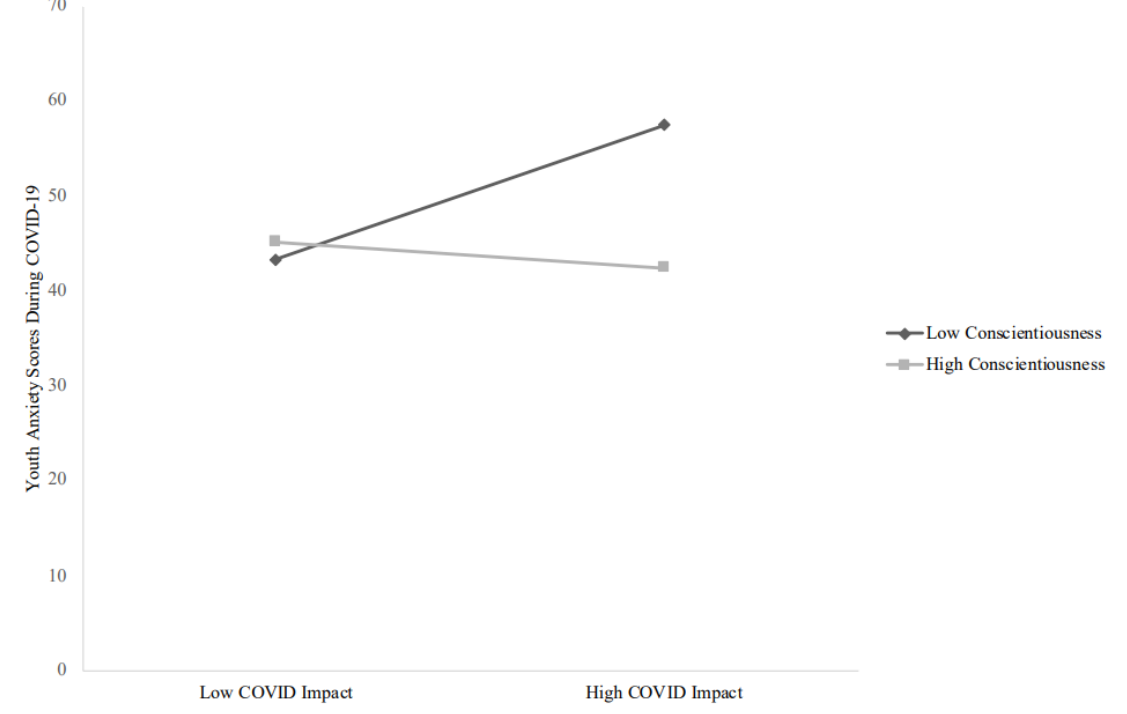
Figure 1. Interaction between COVID-19 impact and levels of conscientiousness on change in youth anxiety symptoms during COVID-19. Note: effects of COVID-19-related personal impact on mental health are depicted at ±1 standard deviation of the moderator. Table 4. Regression models predicting parent mental health during the COVID-19 pandemic. Predicting parent mental health during the COVID-19 pandemic from COVID-19 im- pact and personality vulnerability (Table 4).